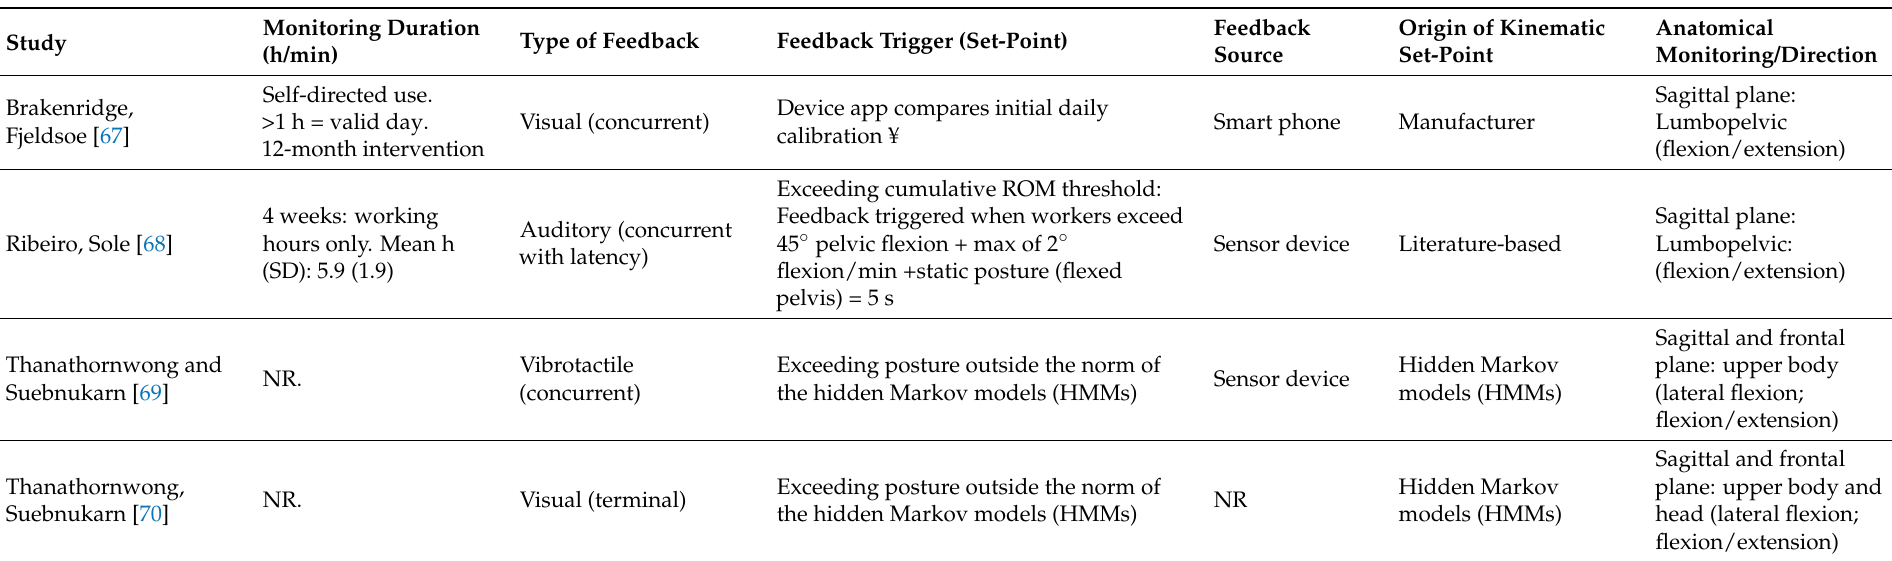
Table 4. Technical characteristics of wearable inertial sensor technology (WIST) feedback in each of the included